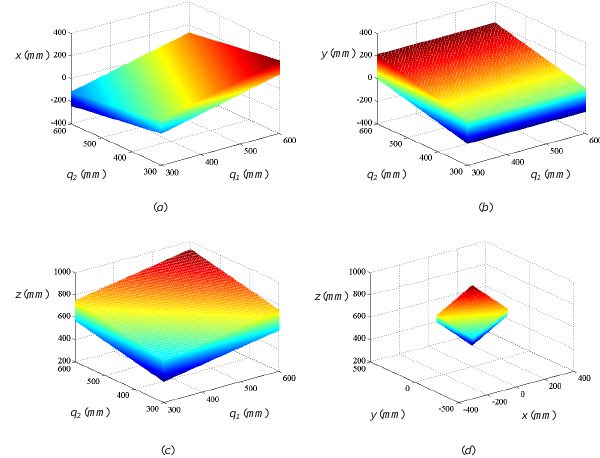
Figure 11. The workspace of the manipulator.